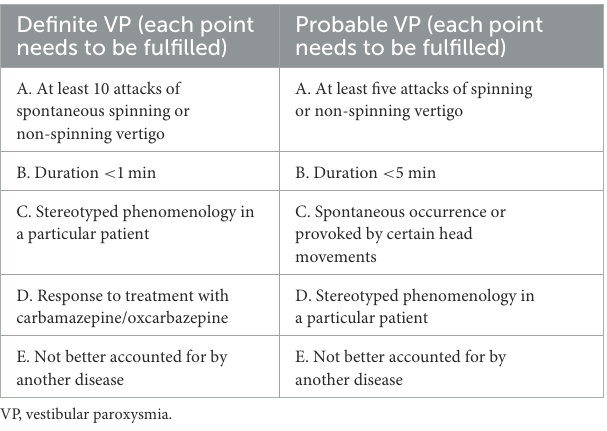
TABLE 1 Diagnostic criteria for VP according to the Bárány Society.